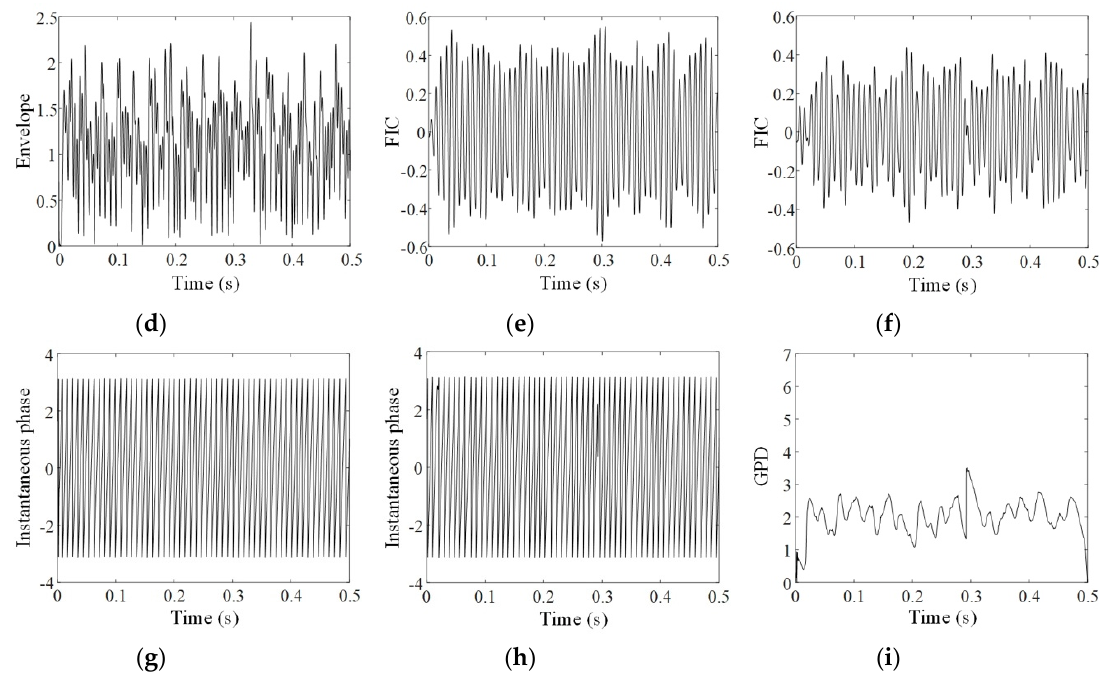
Figure 6. PSA of the 120th minute vibration signals: ( a ) horizontal signal; ( b ) vertical signal; ( c ) envelope of horizontal signal; ( d ) envelope of vertical signal; ( e ) FIC of horizontal signal; ( f ) FIC of vertical signal; ( g ) instantaneous phase of horizontal FIC; ( h ) instantaneous phase of vertical FIC; ( i ) GPD of vibration signals.